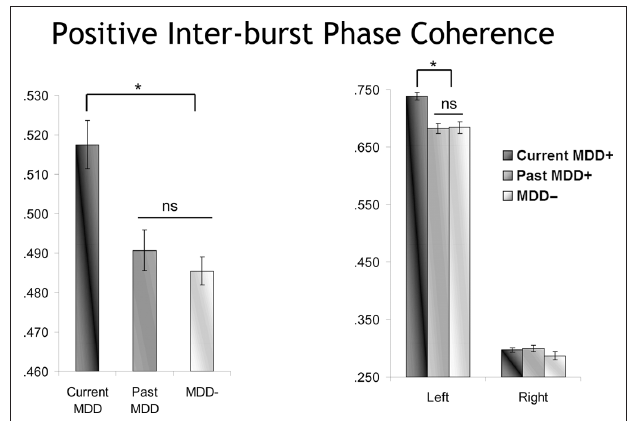
FIGuRE 11 | Topographical distribution of positive (A) and negative (B) bursts for alpha oscillation power and alpha oscillation inter-burst phase